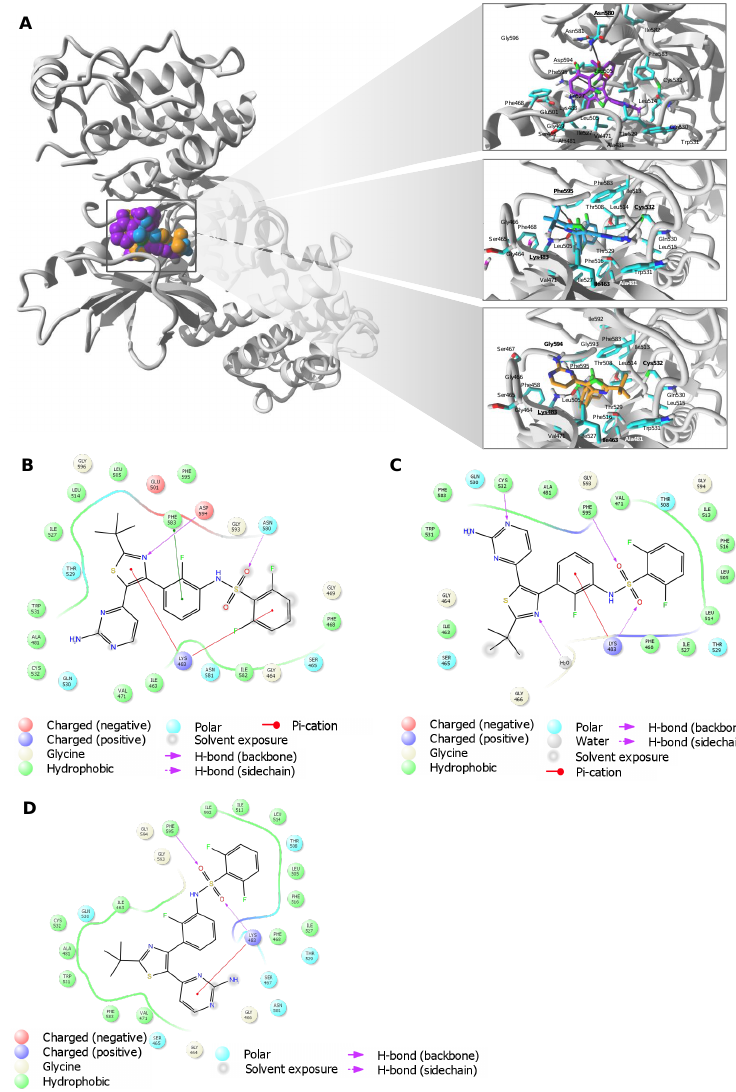
Figure 2. Molecular docking of dabrafenib to the human BRAF kinase V600E or D594G mutant model. ( A ) Dabrafenib binding site (purple) in the BRAF kinase V600E mutant is presented as the energetically lowest orientation. Moreover, two of the energetically lowest orientations (orange and light blue) are shown in the complex with the BRAF kinase D594G mutant model. On the right, 3D views of dabrafenib interactions with residues involved in binding. Hydrogen bonds are marked with black arrows and residues are underlined. Ligand orientations are rendered as a ball mode (on the left) and as a stick mode (on the right), whereas residues involved in ligand binding (on the right) are rendered as a stick mode (element color code with nitrogen presented in blue, oxygen in red, and hydrogens in white). ( B ) 2D views of dabrafenib interacting with the binding site in the BRAF kinase V600E mutant and ( C , D ) 2D views of dabrafenib binding in two (higher-affinity and lower-affinity) orientations in the BRAF kinase D594G mutant. Residues involved in dabrafenib binding are presented in panels ( B – D ). Hydrogen bonds are marked with pink arrows, residues involved in hydrophobic